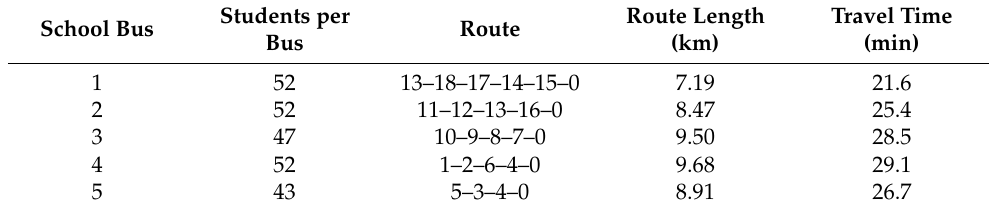
Table 4. School-bus route.